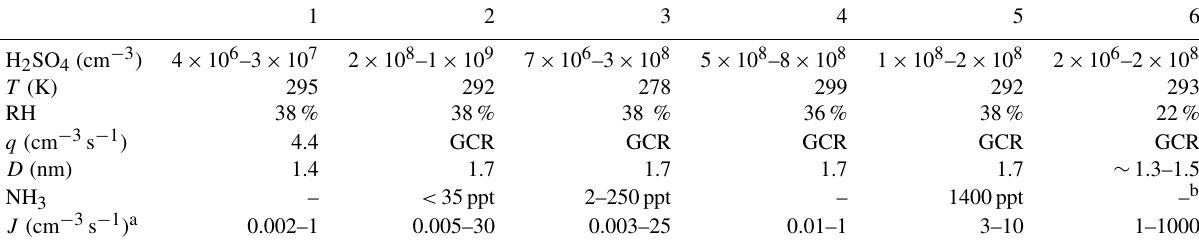
Table 3. Comparison of similar nucleation rate experiments. The numbers refer to the different studies: 1 is this study, 2 is Kirkby et al. (2011), 3 is Almeida et al. (2013), 4 is Duplissy et al. (2016), 5 is Kürten et al. (2016), and 6 is Sipilä et al. (2010). The fifth parameter, D , is the mobility diameter. GCR corresponds to the background GCR (galactic cosmic ray) ionization ( ∼ 3cm − 3 s − 1 ). Cells with a dash mean that the value was not measured or